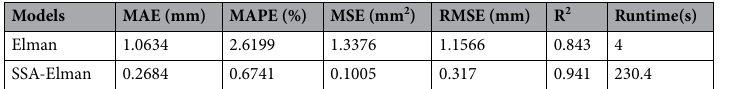
Table 9. Evaluation index value and average running time of Elman, SSA-Elman at P2.